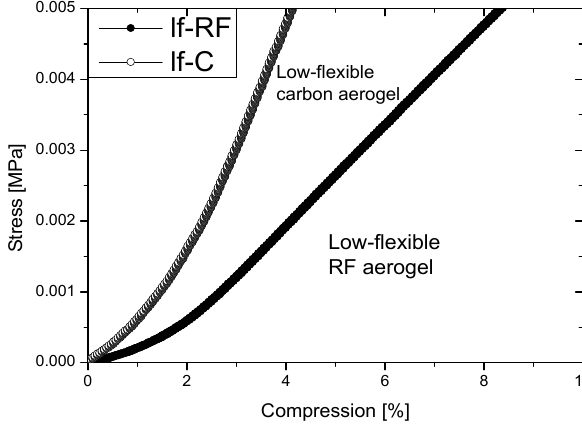
Figure 5. Compression curves of low-flexible aerogels.